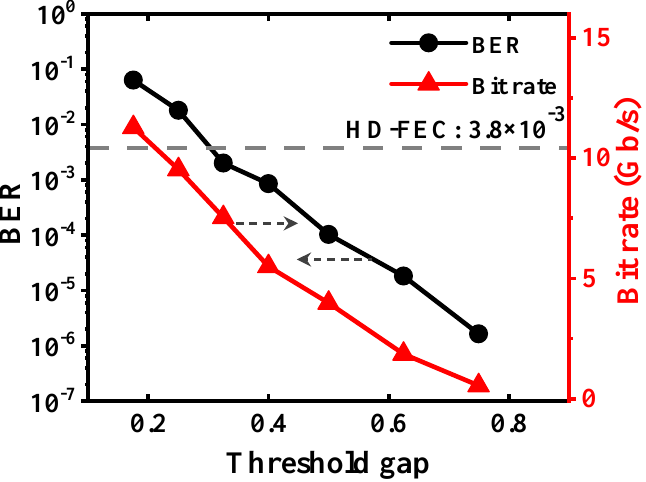
Figure 8. BER and bit rate versus threshold gap.